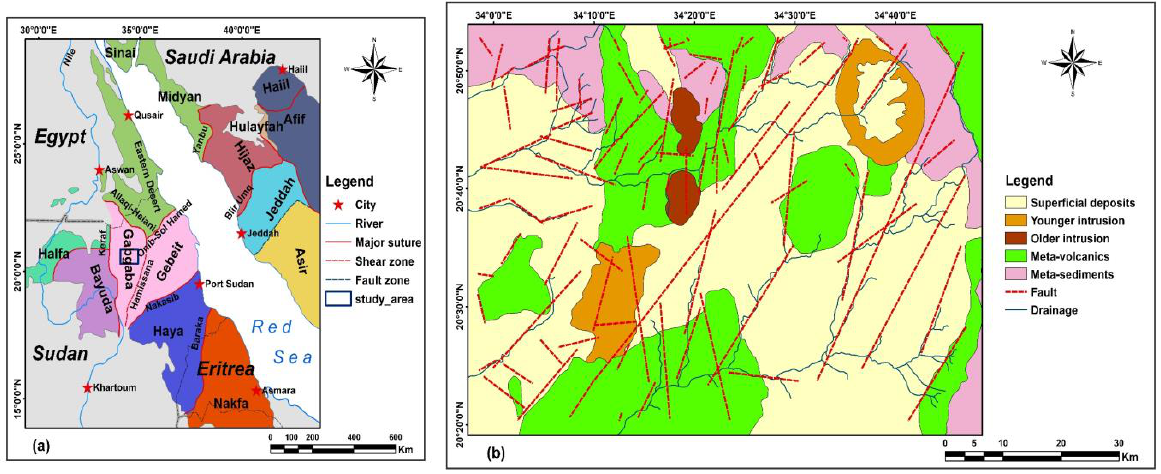
Figure 1. Location of the study area. ( a ) Sketch map of the main terranes, major suture, and shear zones of the Arabian-Nubian shield in the Red Sea Hills Region of Sudan (modified after Bierlein et al. [43]); ( b ) geological map of the study area (modified after Mohamed et al.